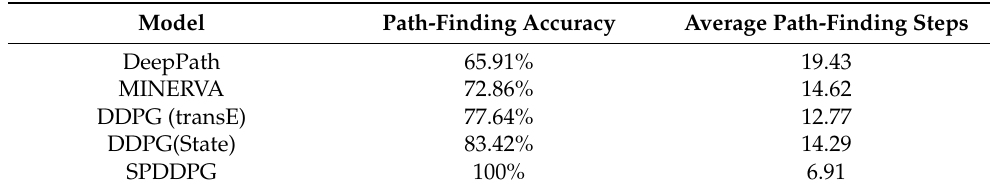
Table 2. The comparison of experimental